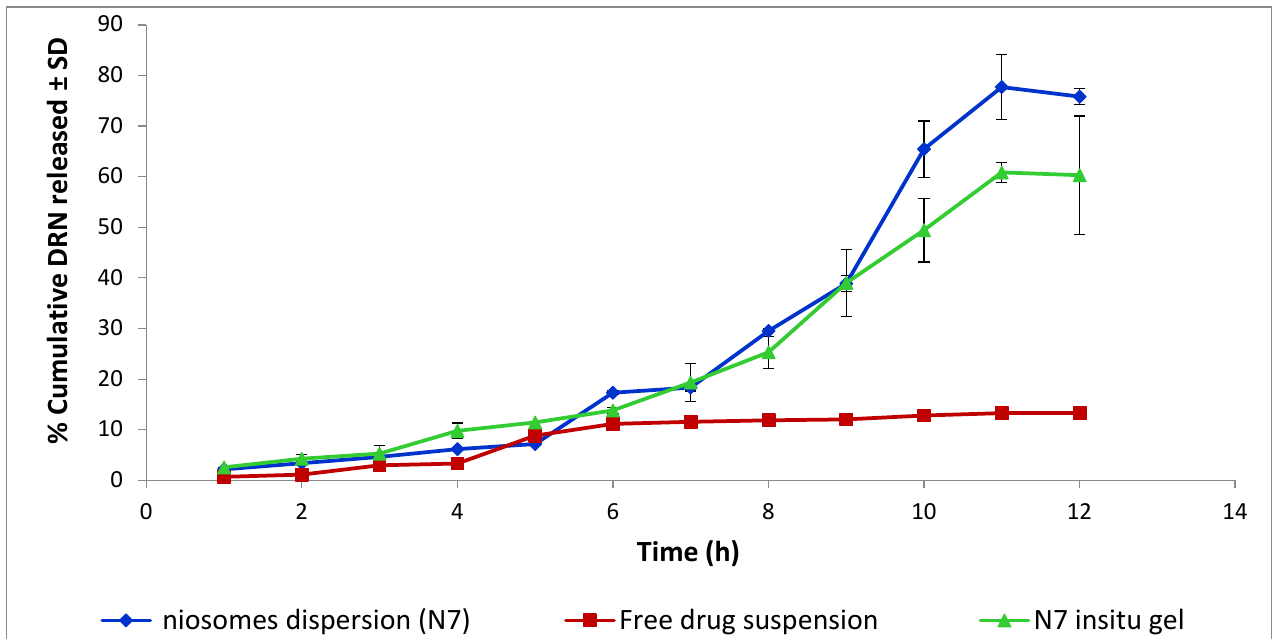
Figure 5. Release profile of DRN niosomes dispersion (N7), N7 in situ gel and free DRN suspen- sion.